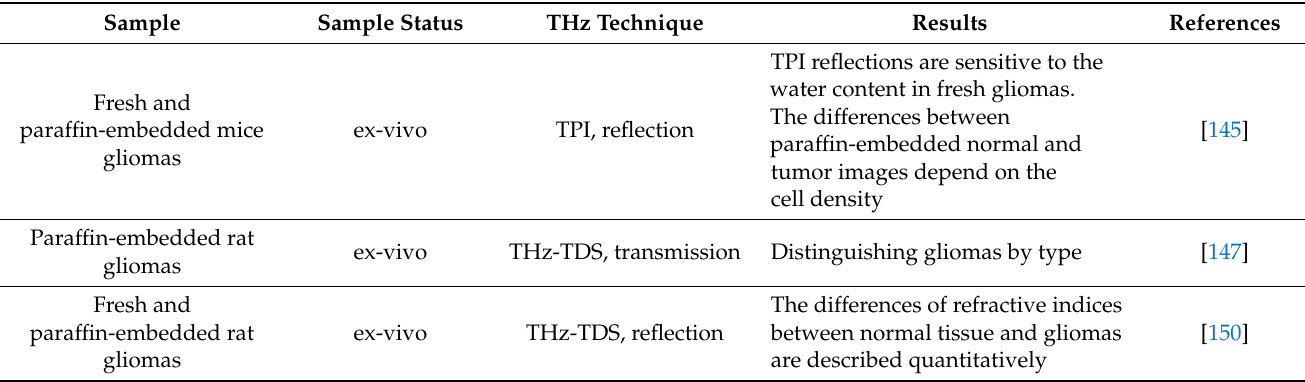
Table 1. Results of studying gliomas by THz